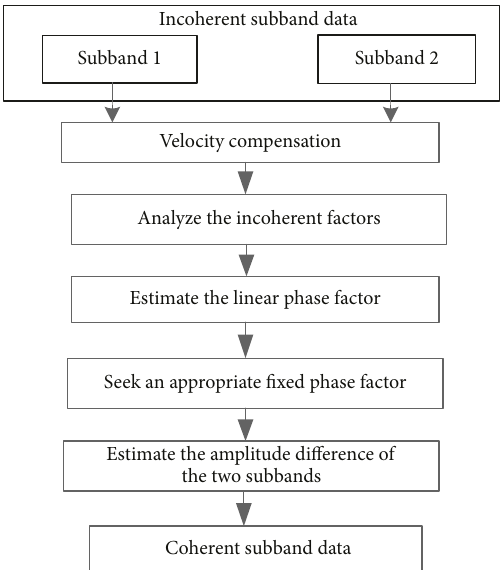
Figure 1: The influence of varied target velocity on range profile.